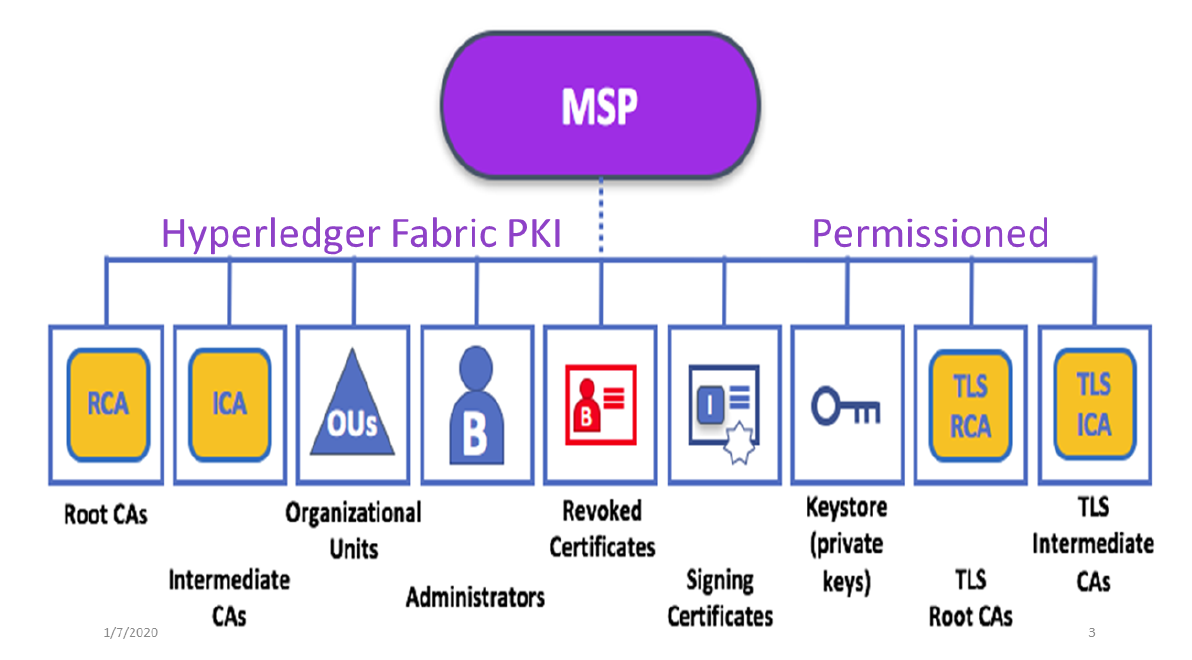
Figure 1. MSP Architecture. Source: Hyperledger